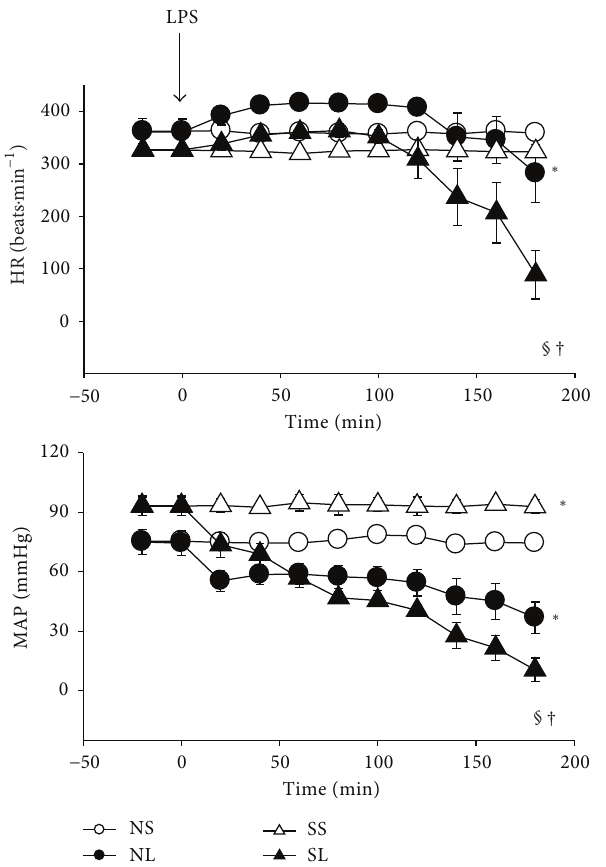
F 3: Changes in cardiovascular parameters in normal and diabetic rats during the administration of saline or LPS (15mg/kg, i.v.).HR:heartrate;MAP:meanarterialpressure.Dataareexpressed